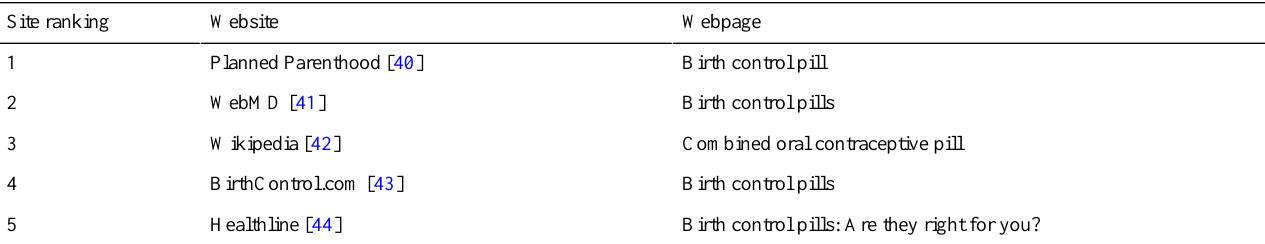
Table 4. Top five sites visited for birth control pill searches in the United States in August 2018. WebpageWebsiteSite